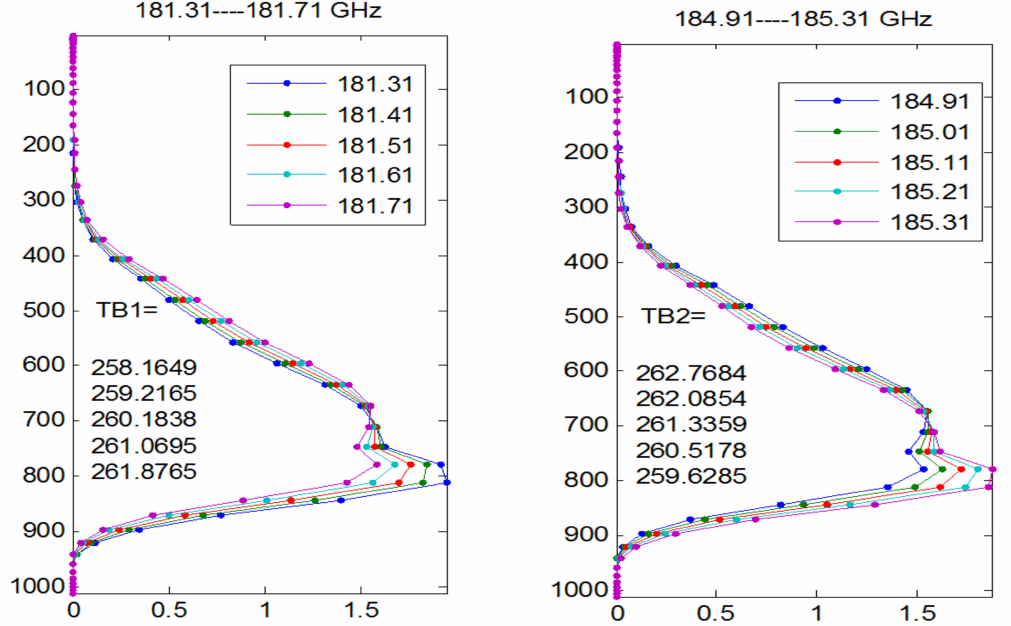
Figure 3. Weighting functions distributed from surface to 30 hPa for 183